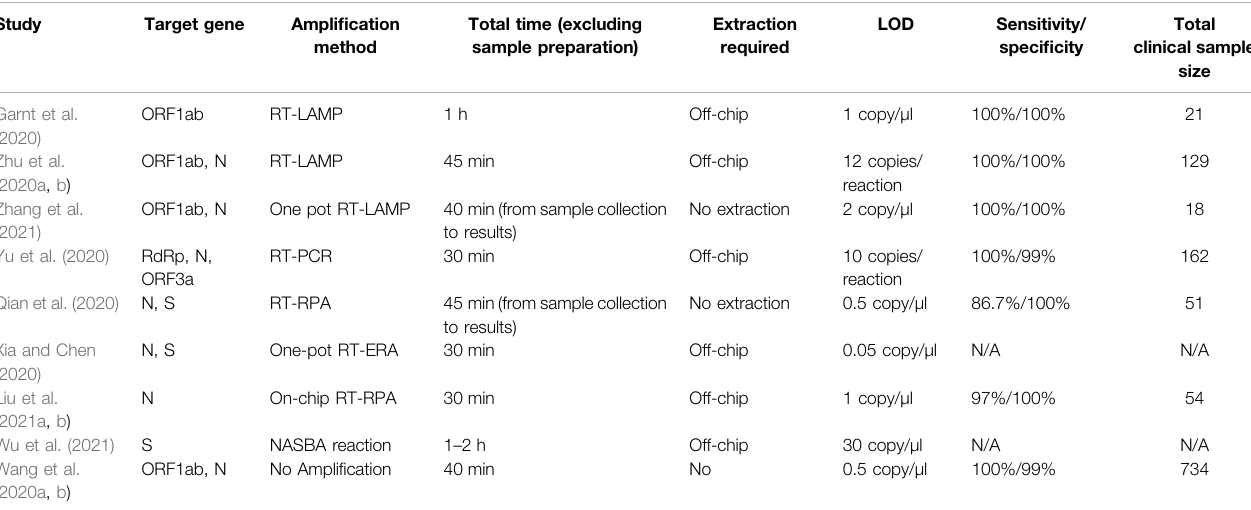
TABLE 2 | Existing paper-based nucleic acid